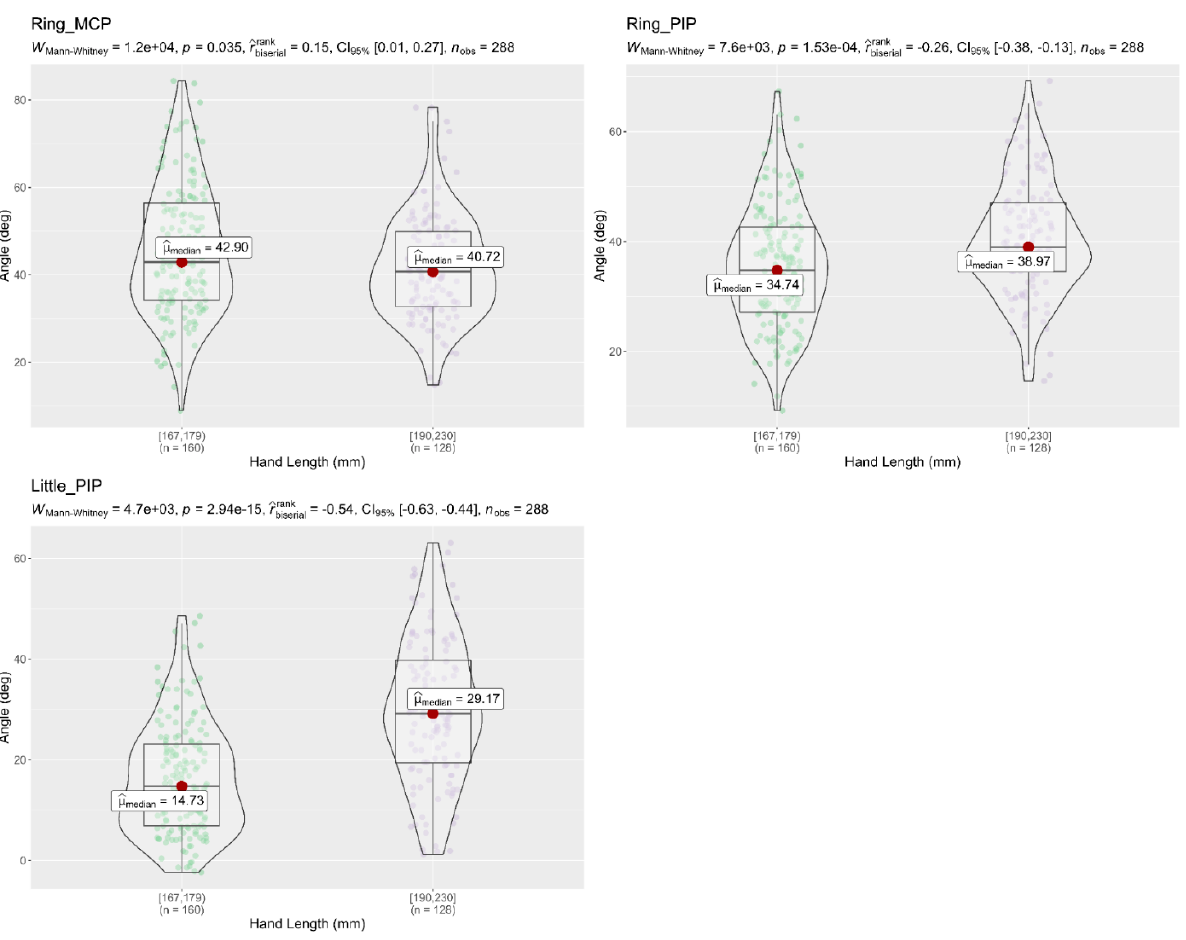
Figure 10. Mann–Whitney U test of flexion angle in finger joints with respect to different hand length groups; The figure only shows the finger joints in which significant differences were found (Ring MCP, Ring PIP, Little PIP); p < 0.05, significantly different; deg =